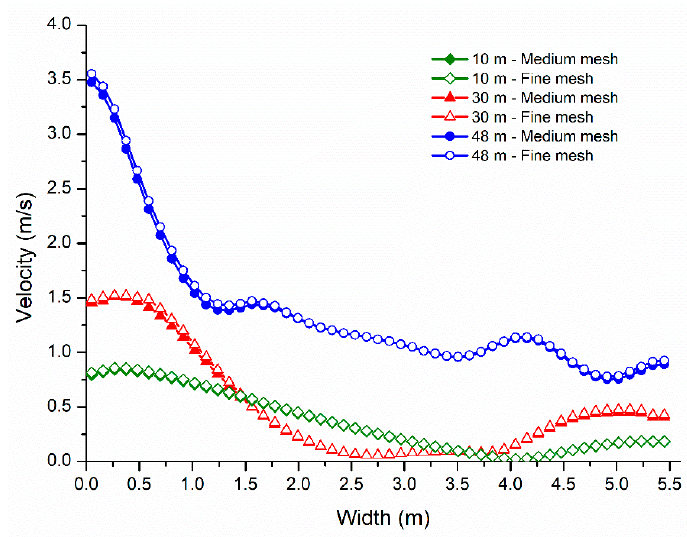
Figure 3. Airflow velocities at monitoring lines.